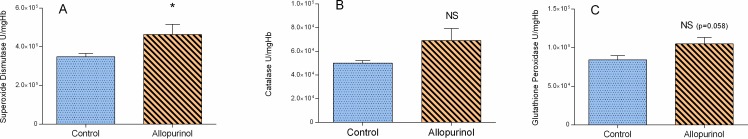
Effect of XO inhibition by allopurinol (50mg/kg) on activity of antioxidant enzymes in erythrocyte lysate: superoxide dismutase (A), catalase (B), glutathione peroxidase (C). Blue bar indicates control group, orange bar–rats treated with allopurinol. Data shown as mean ± SEM * p<0.05, NS–non-significant, allopurinol vs. control group (N = 8; Fig A: Mann-Whitney test; Fig B and C: t-test).